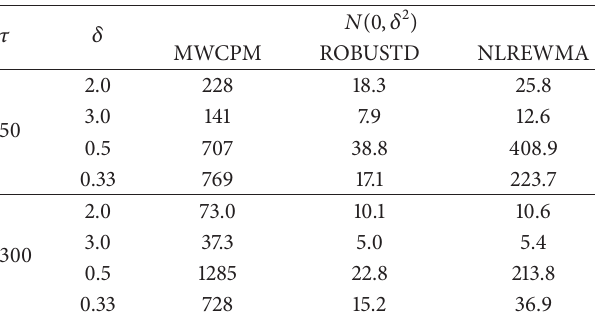
Table 2: ARL 1 (𝛿) for dispersion shifts in the 𝑁(0, 1) distributions, for several values of the change time 𝜏 .